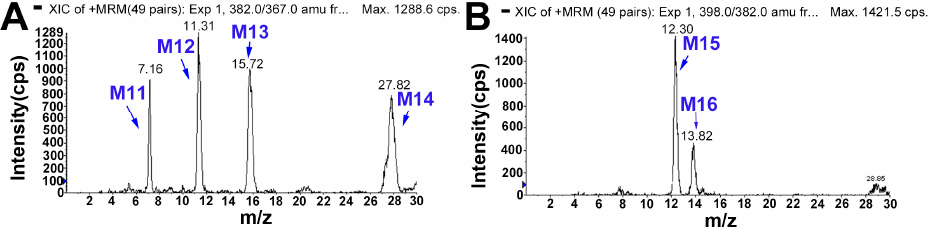
Figure 3. The extracted ion chromatograms (XICs) of dehydrocorydaline (DHC) metabolites in bile. ( A ) Hydroxylated metabolites, and ( B ) di-hydroxylated metabolites.